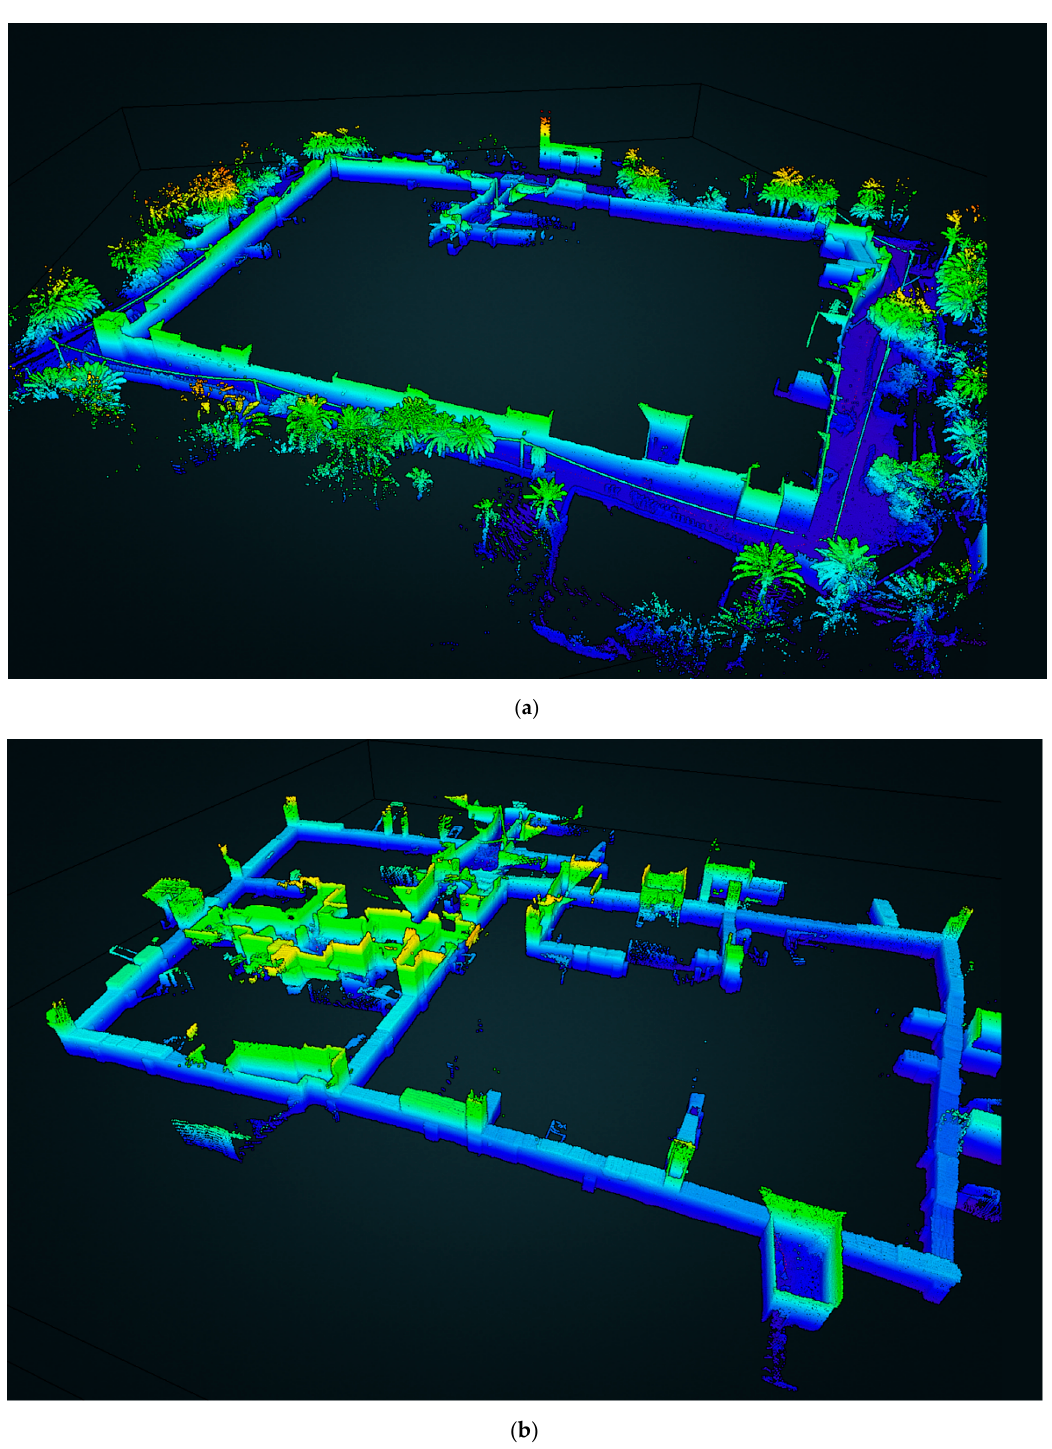
Figure 17. The village of Mansouria from Google Earth.